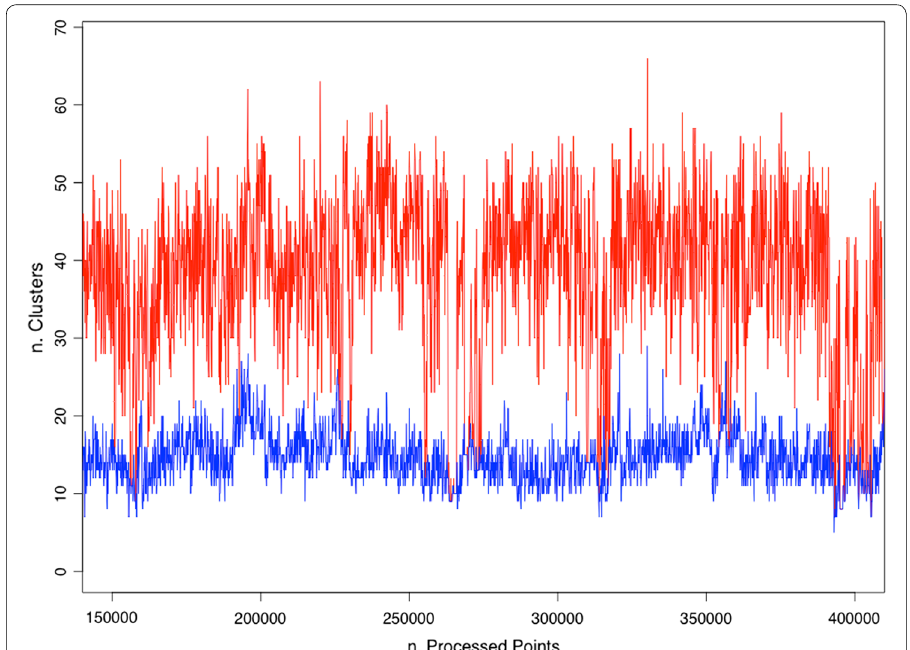
Fig. 5 Effect of the secondary compression. Red line: number of clusters obtained before secondary com- pression. Blue line: number of clusters obtained after secondary compression. Secondary compression is applied once out of 100